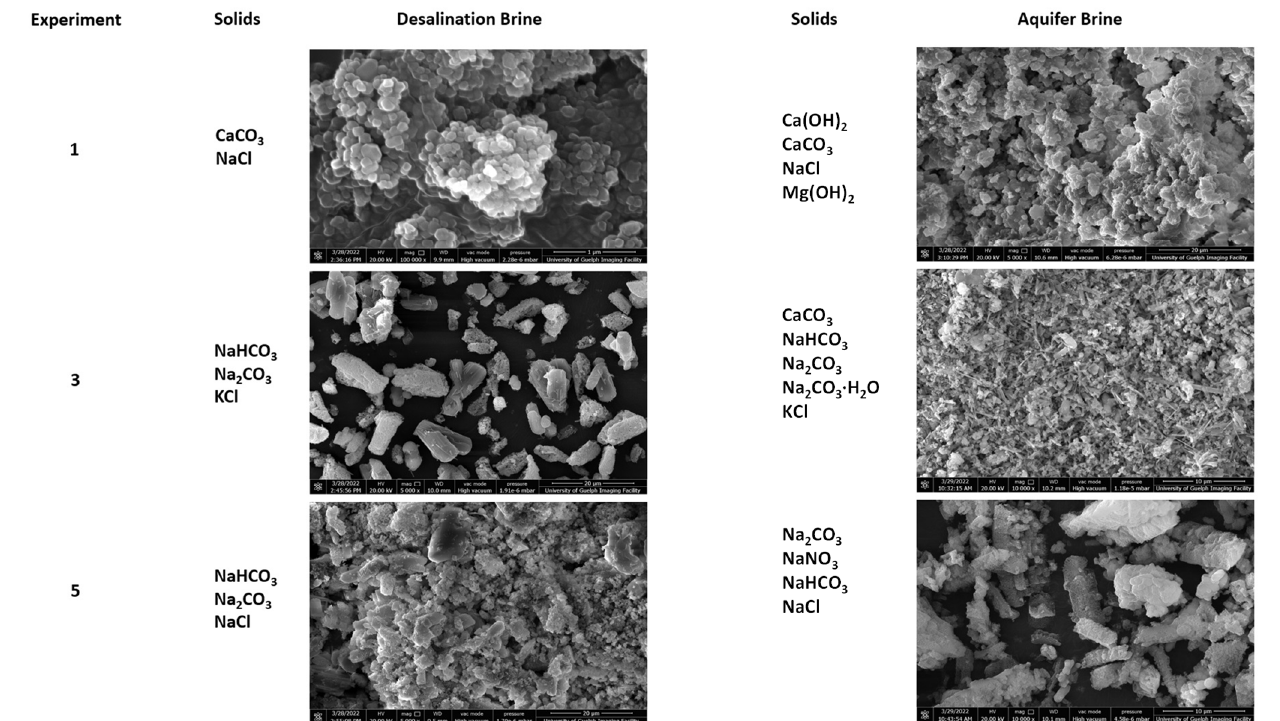
Figure 3. SEM images of the powders obtained from experiments 1 ( top ), experiment 3 ( middle ), and experiment 5 ( bottom ) with the desalination brine ( left ) and the aquifer brine ( right ); the mineral phases are listed in decrasing order according to amounts quantified from XRD analysis (Table 1).